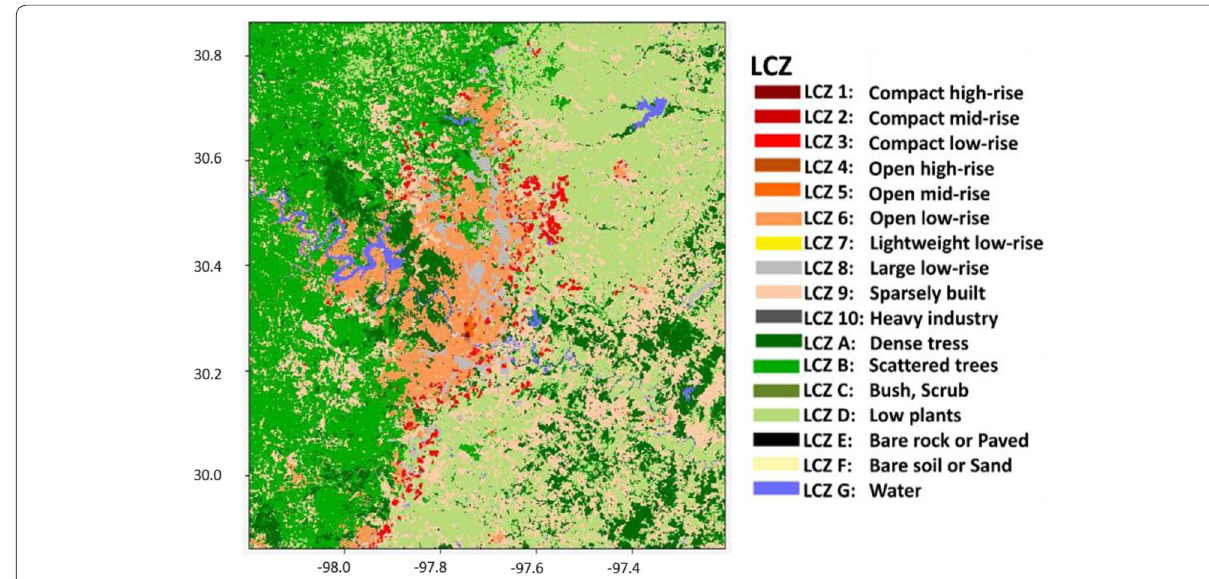
Fig. 14 The LCZ map derived from LCZ Generator